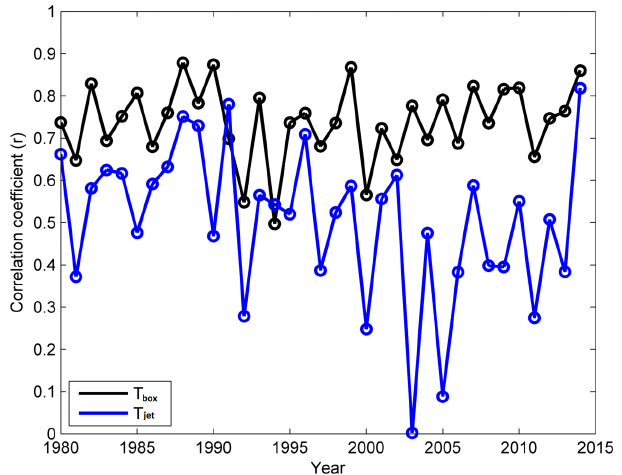
Figure 5. This 34-year annual correlations between the box (black) and jet (blue) transport proxies against the box and jet transports extracted from HYCOM.